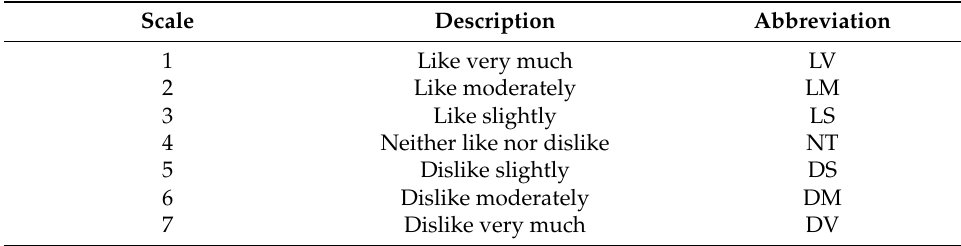
Table 1. Linguistic assessment scale [32].